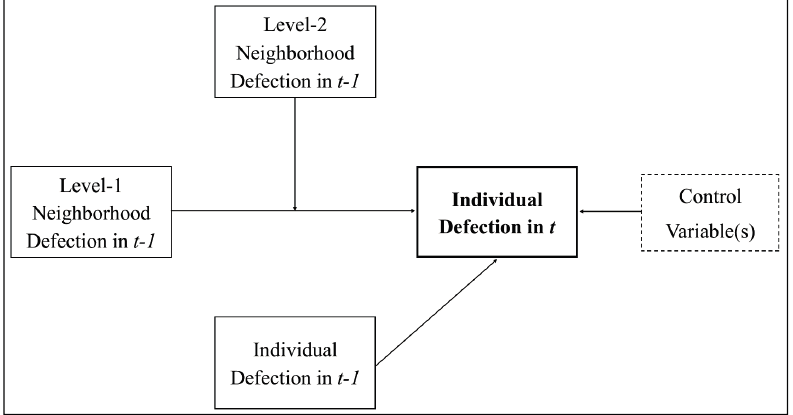
Figure 1. A two-level model of neighborhood effects with cross-level